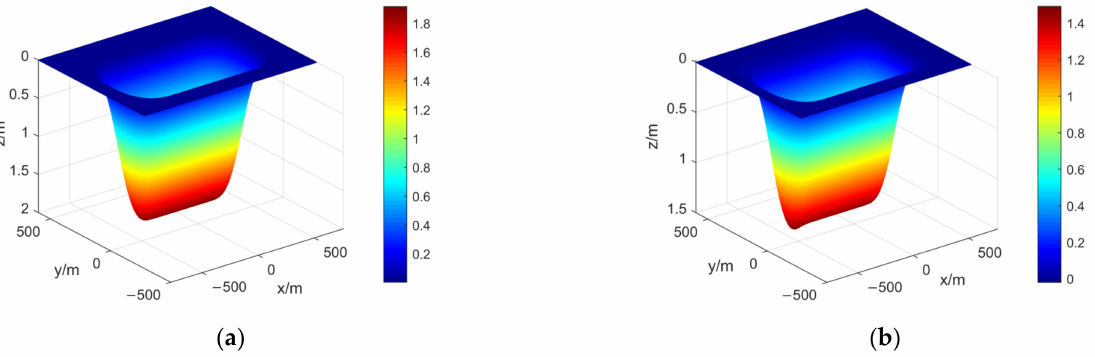
Figure 21. Subsidence basins. ( a ) Subsidence basin by PIM. ( b ) Simulated LOS subsidence basin.